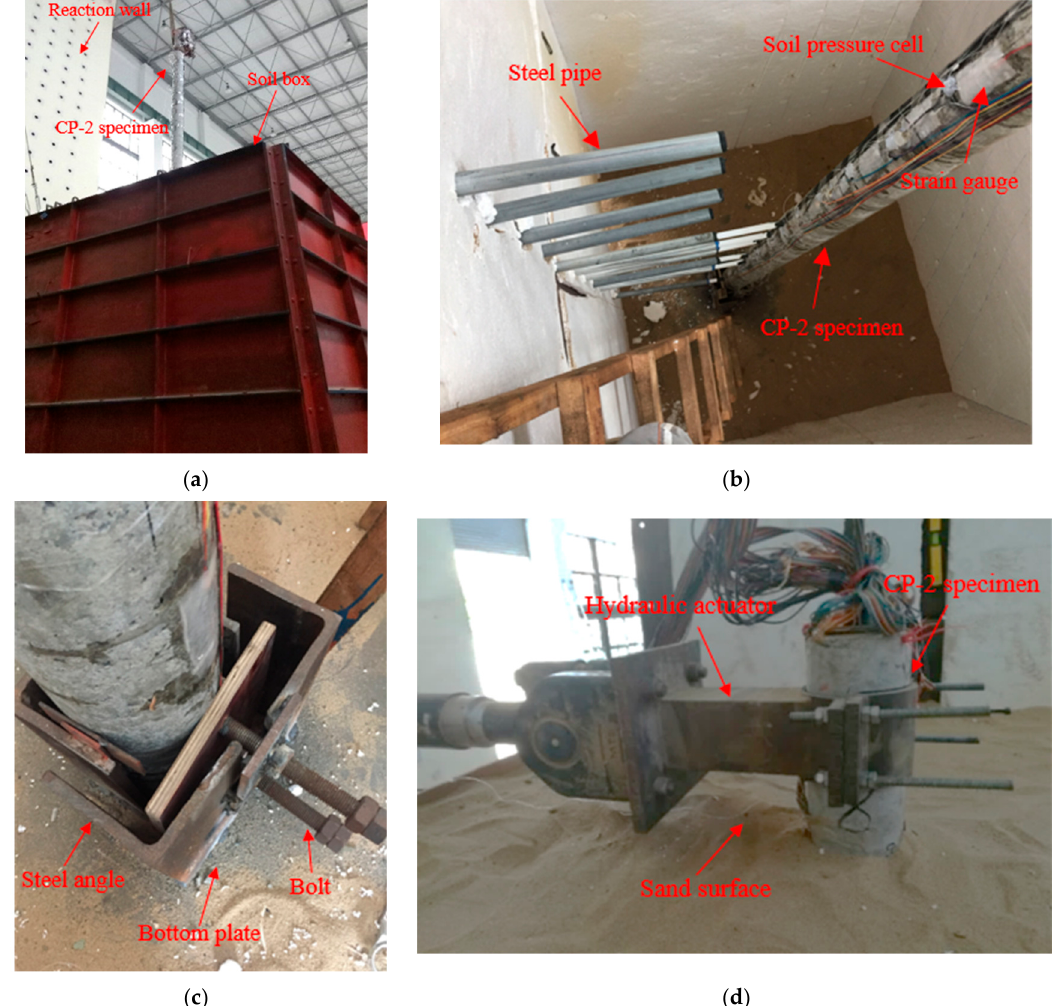
Figure 4. The soil filling process. ( a ) Installation of a specimen. ( b ) Placement and details of a specimen. ( c ) Details of the pile base. ( d ) Fully filled soil box.